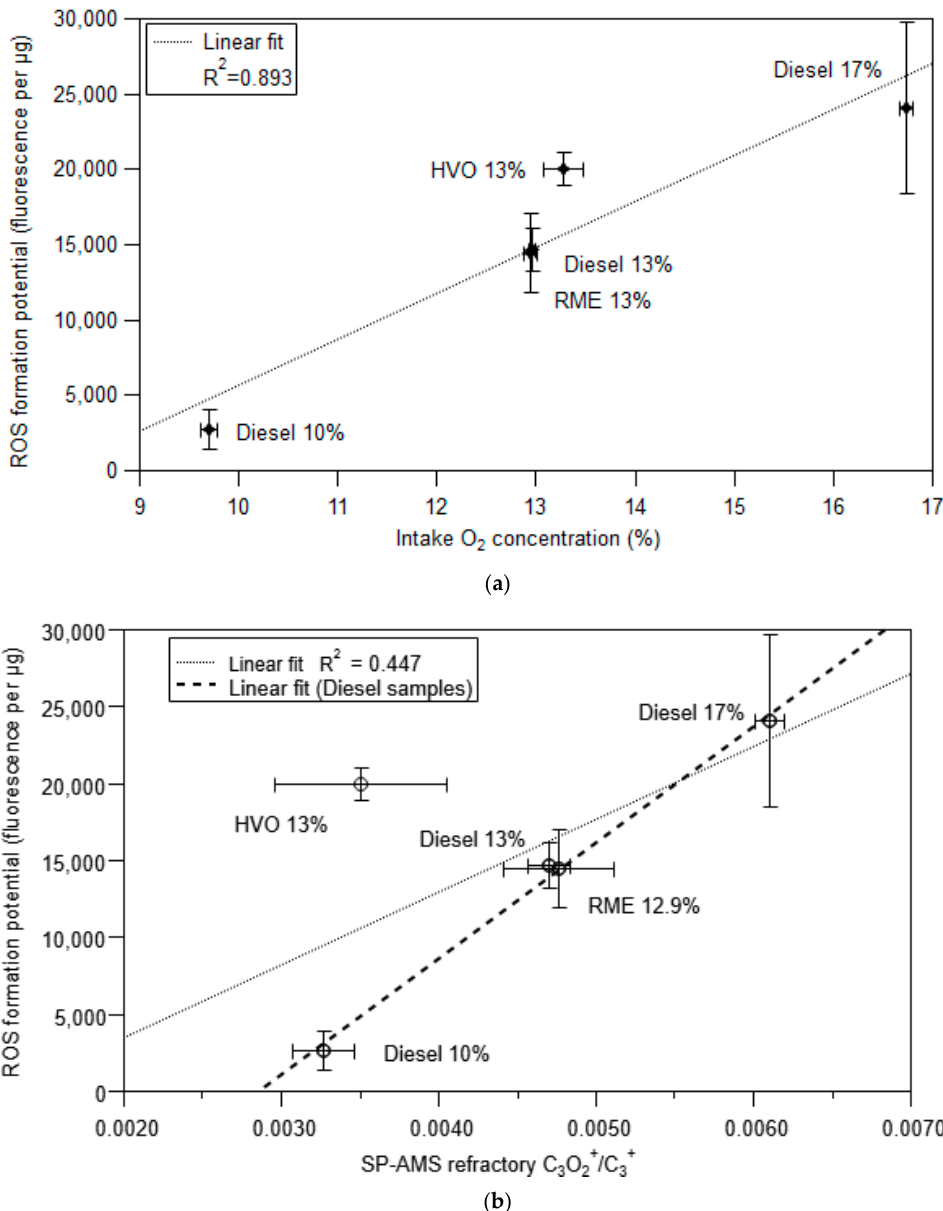
Figure 7. ( a ) Relationship between the reactive oxygen species ROS formation potential per mass unit (with error bars of ±1 standard error of the mean) and intake O 2 concentration (i.e., EGR), and ( b ) relation between the ROS formation potential and the soot particle aerosol mass spectrometer (SP-AMS) refractory C 3 O 2+ /C 3+ fragment ratio. a) Error bars of ±1 std. dev. of the intake O 2 concentration ( b ) Error bars for C 3 O 2+ /C 3+ show ±1 standard error.